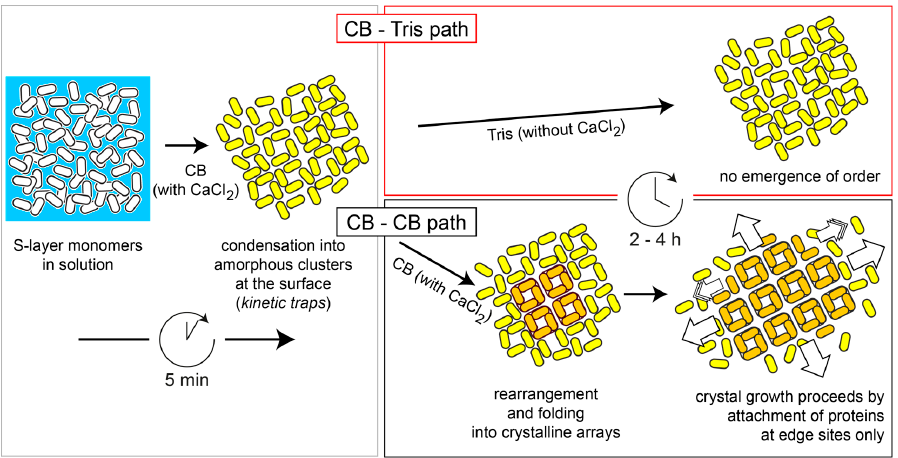
Figure 1. Schematic drawing of the two steps in the non-classical recrystallization process of the rSbpA S-layer protein. Adsorption of extended S-layer protein monomers in crystallization buffer (CB; containing CaCl 2 ) from solution is completed within 5 to 10 min, leading to an irregular but complete coverage of the surface. At the same time, amorphous clusters of partially folded proteins are formed, which eventually transform within 2–4 h into crystalline arrays (in orange color) when crystallization buffer is added (CB–CB path). In the course of this step, the S-layer proteins undergo a refolding step into a more compact tetrameric form (in orange color). Crystal growth proceeds by attachment (and refolding) of new proteins at the edge sites of the growing lattice. In contrast, no crystalline lattice is formed (even not overnight) when only Tris—and no crystallization buffer is added (CB–Tris path).